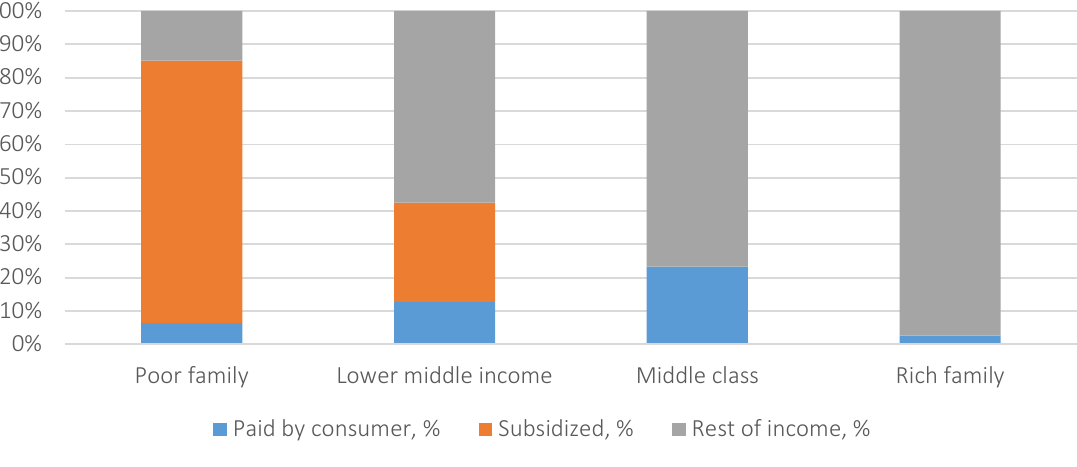
Figure 5. Four cases of the share of utility rate in monthly household income,